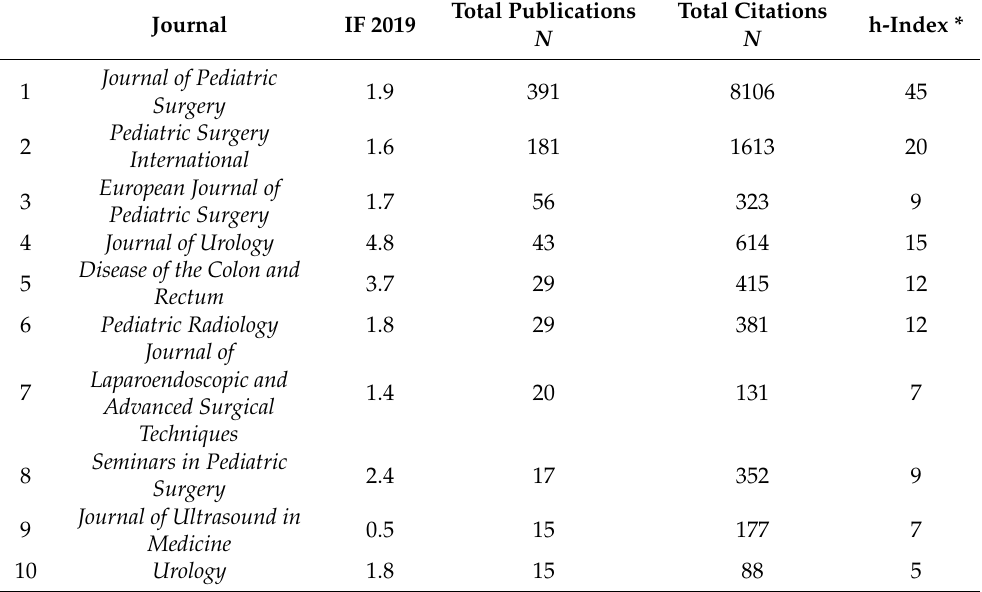
Table 3. Most productive journals reporting on ARM between 1970 and 2020.